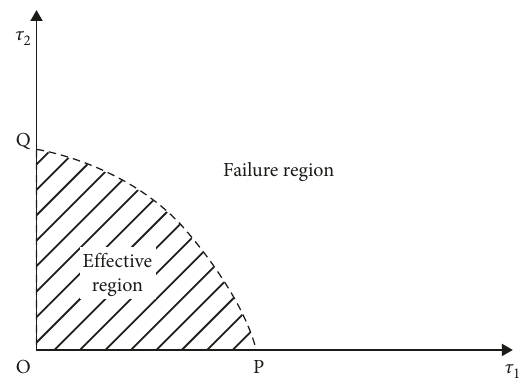
Figure 24: Relation of the time delay boundary curve and per- formance of semiactive